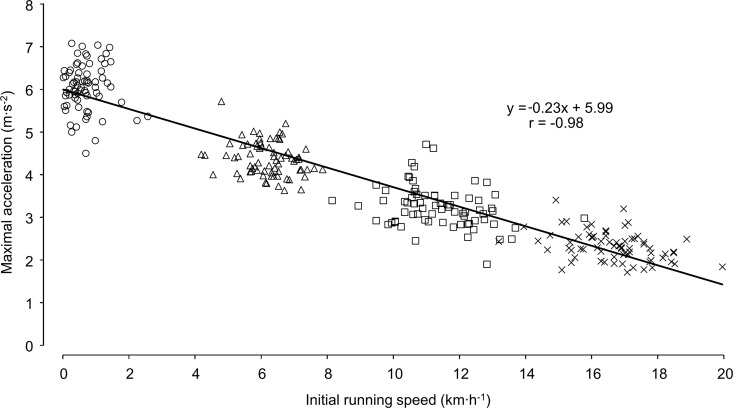
Maximal voluntary accelerations for standing (circles), trotting (triangles), jogging (squares), and running (crosses) of 72 highly trained male soccer players (under 18 league).Simple linear regression line with regression equation and Pearson’s correlation coefficient r.